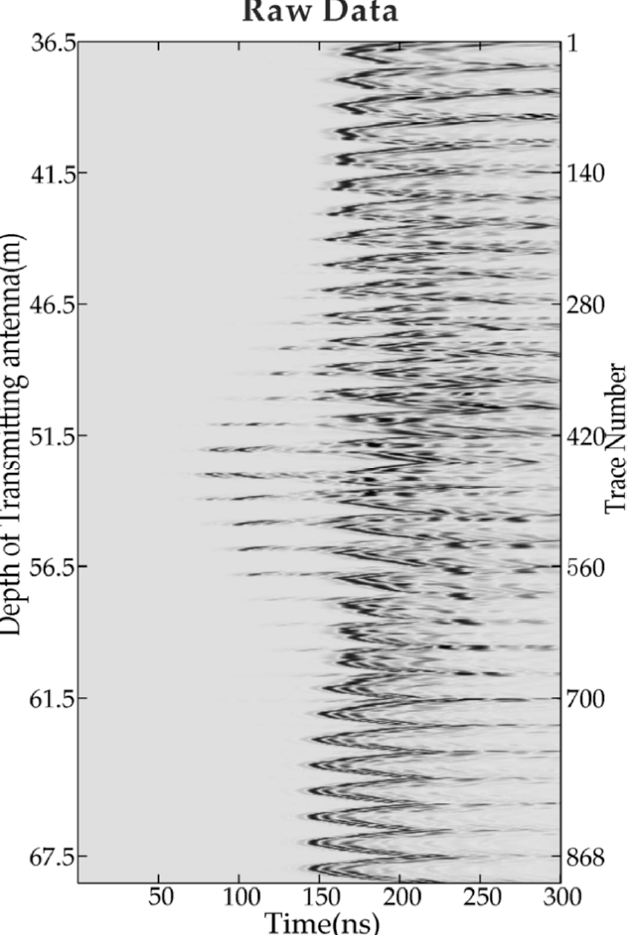
Figure 9. Measured original data of Xiuyan foundation.